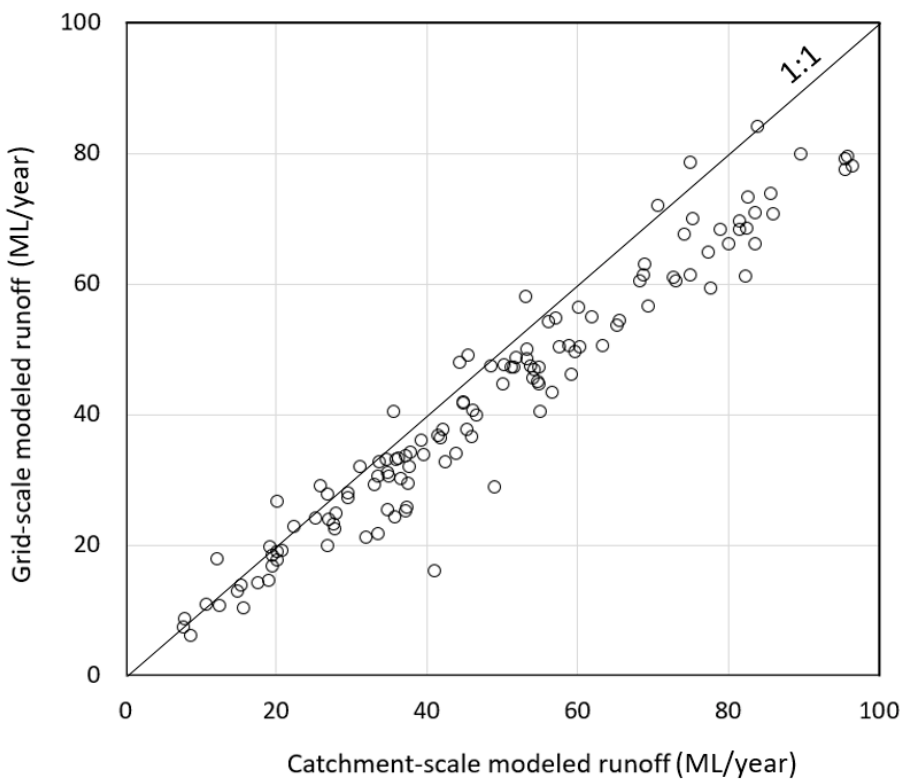
Figure 3. Comparison between grid-scale and catchment-scale runoff estimates from swTELR for all Salinas catchments ( n = 131).